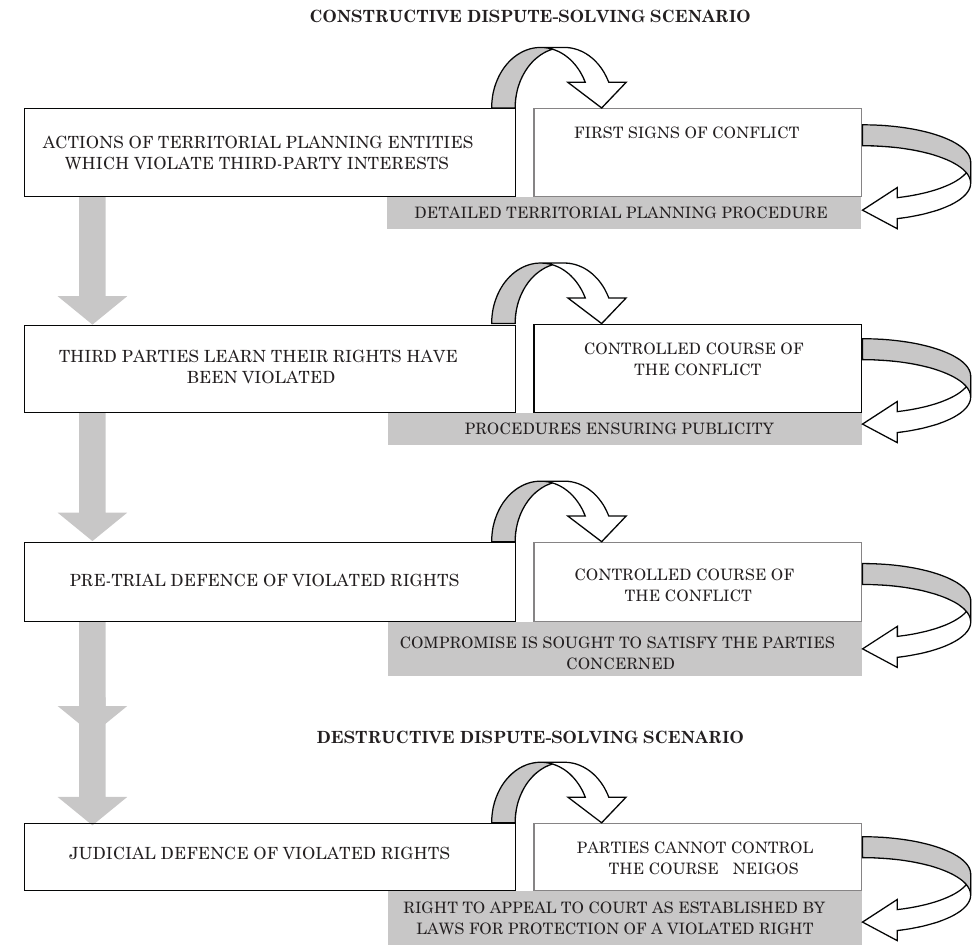
Figure 2. Conflict-solving continuum among entities involved in detailed territorial